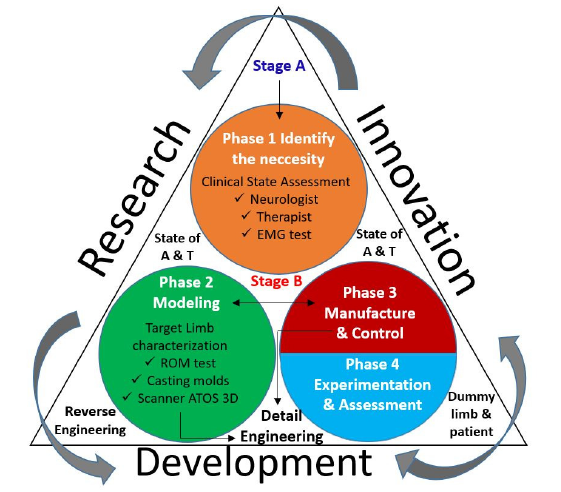
Figure 1. Structure of the design methodology for soft wearable devices